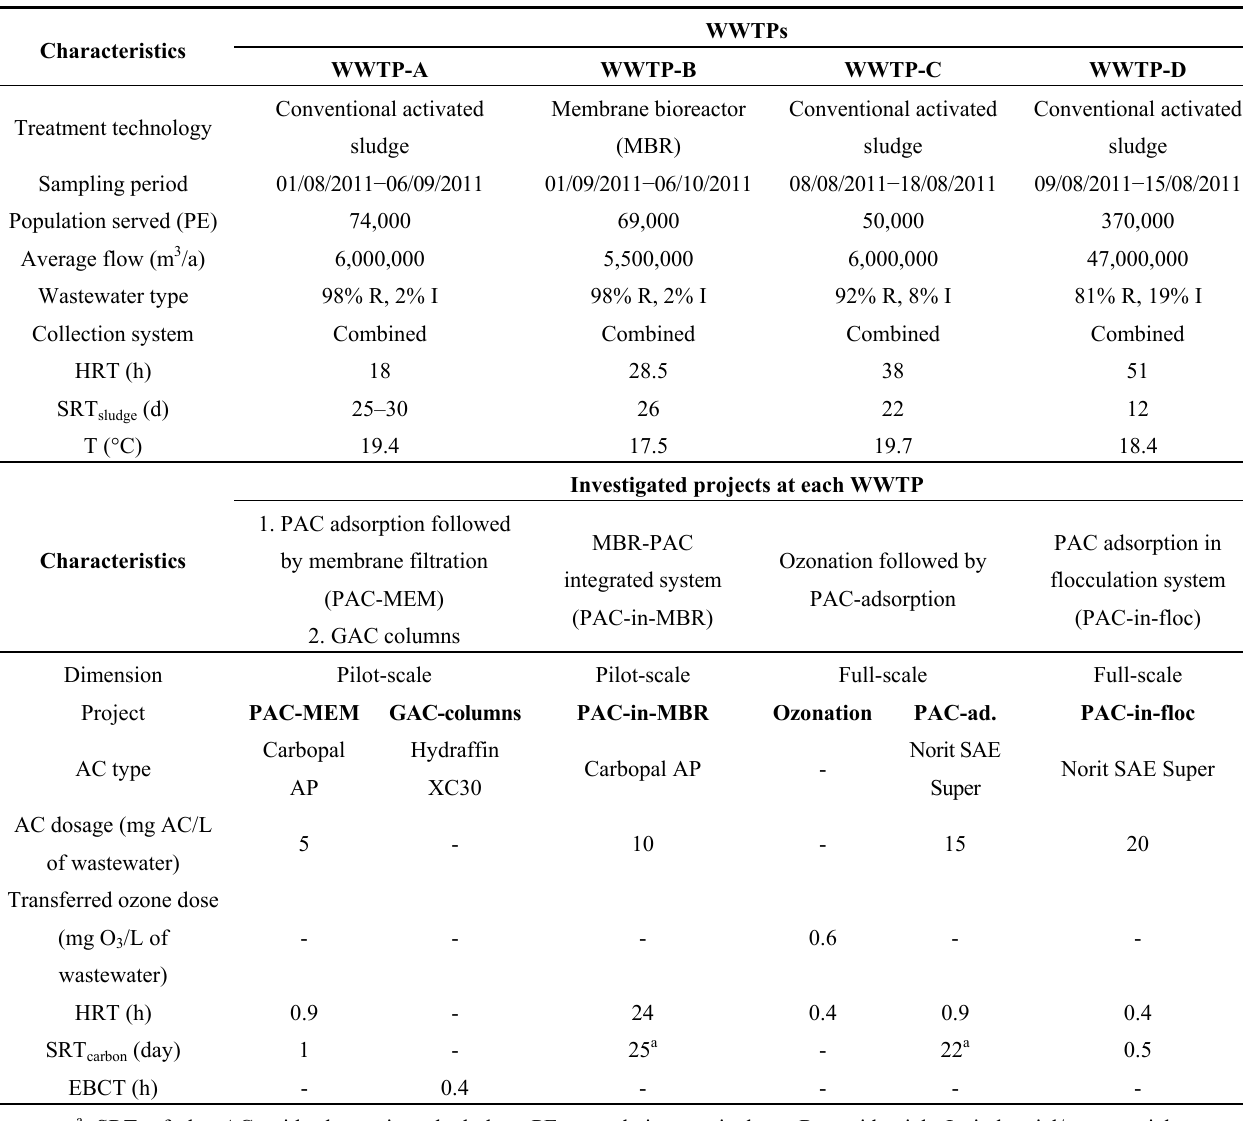
Table 1. Characteristics, operating conditions and description of the pilot- and full-scale projects at the investigated WWTPs during the sampling